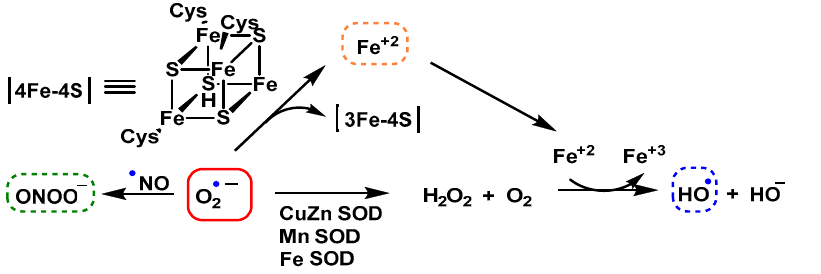
Figure 6. Generation of hydroxyl radical, peroxynitrite and hydrogen peroxide by the O 2•–